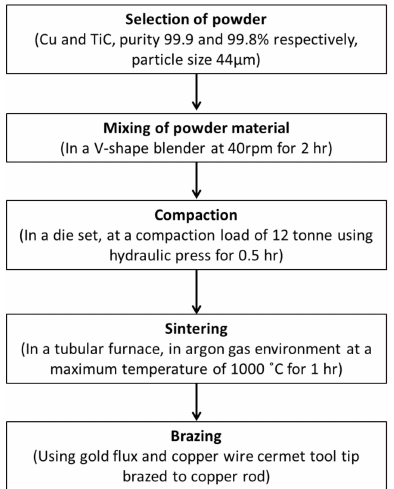
Figure 1. Procedure of fabrication of the cermet tool tip electrode.